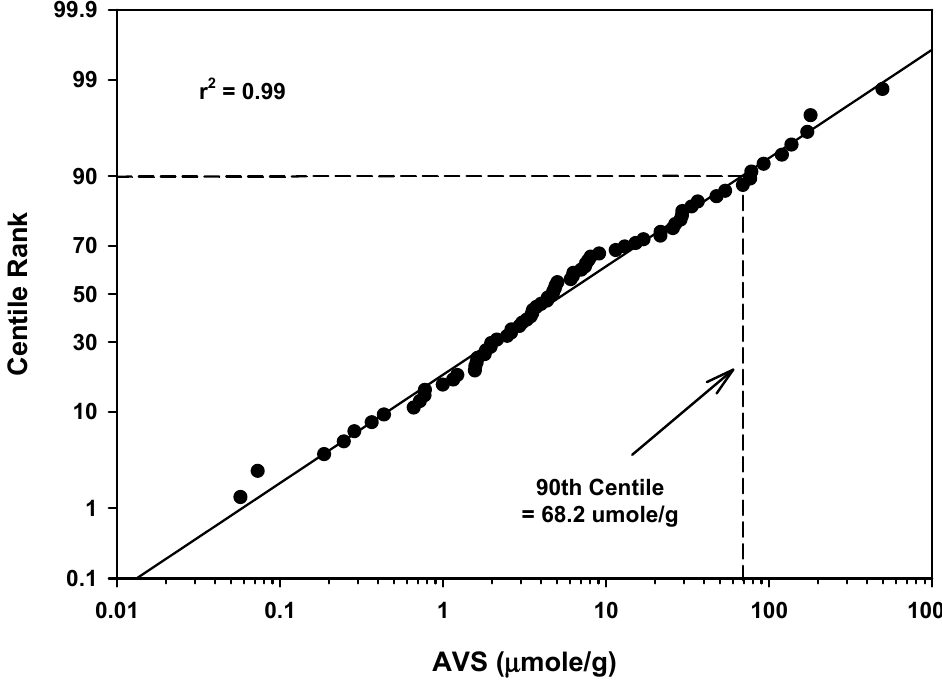
Figure 8. Regression of AVS field study means data for estuarine/marine waterbodies against a probability scale showing the 90th centile rank.